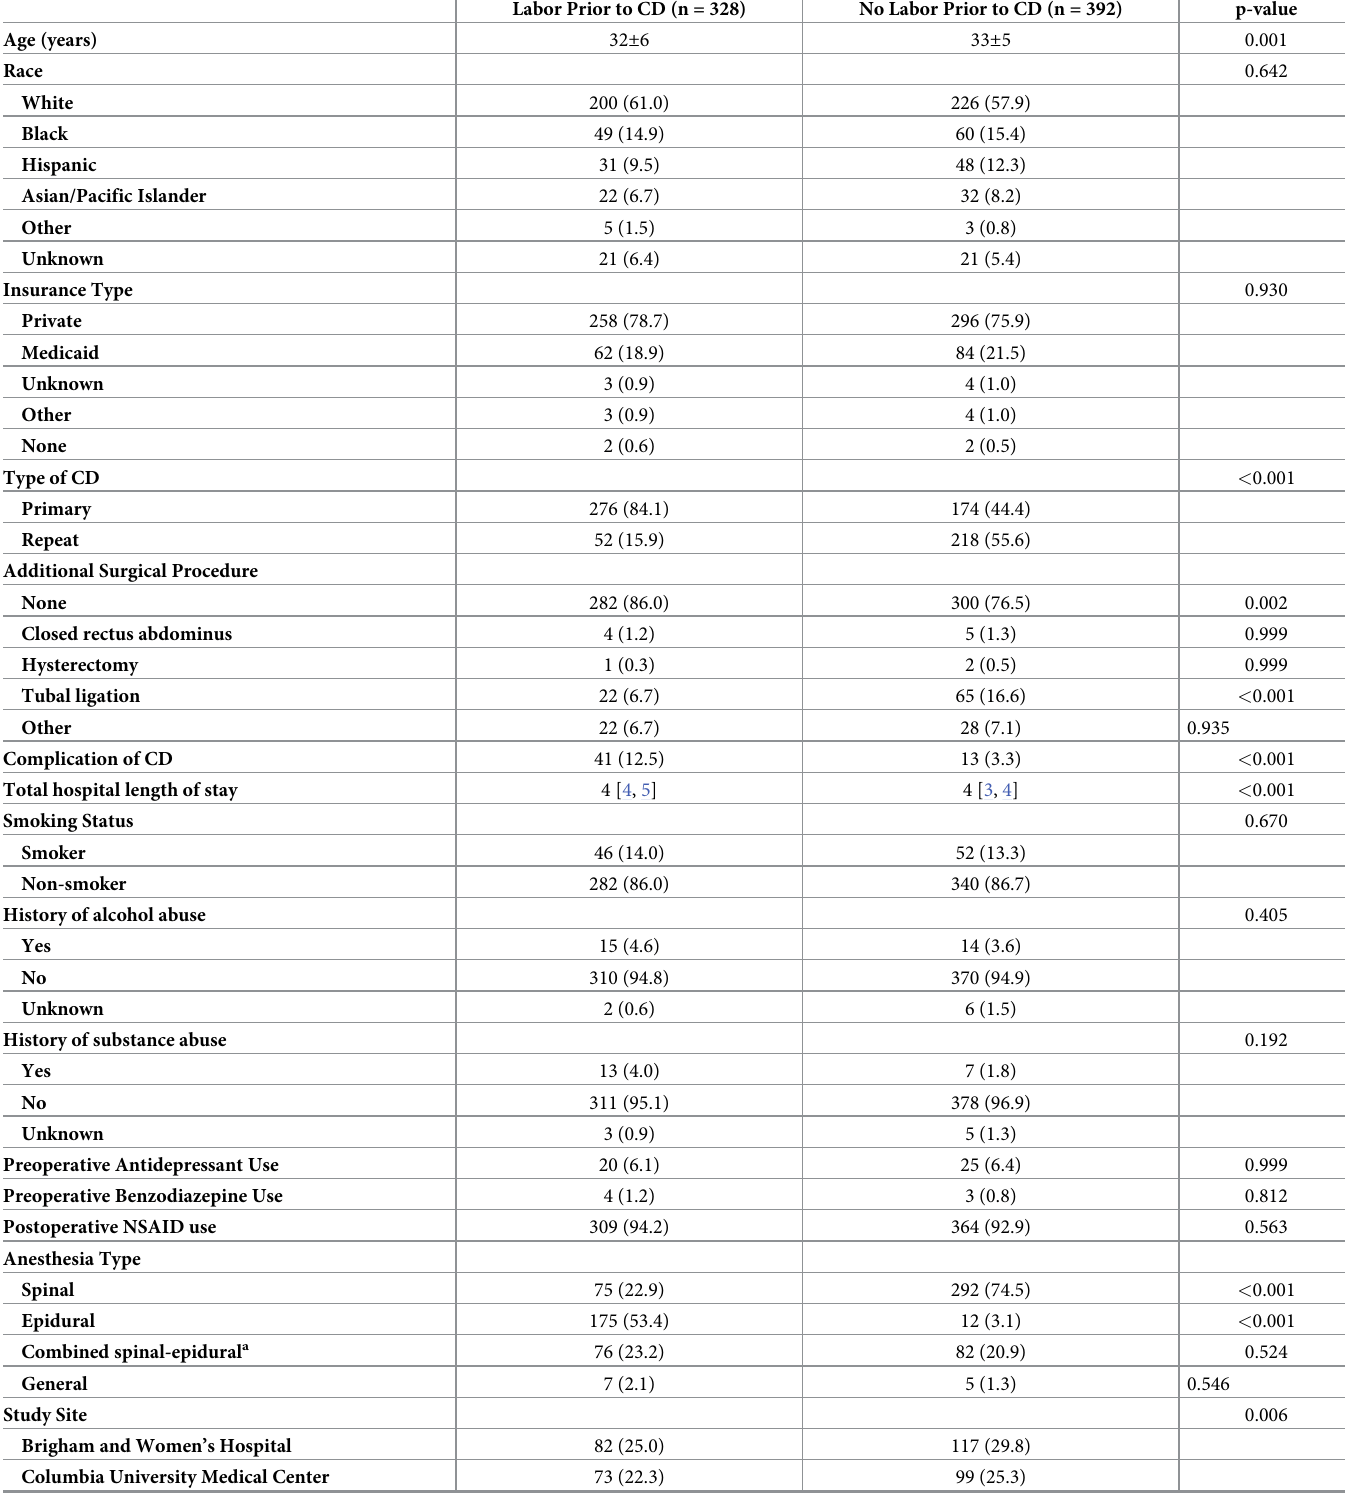
Table 1. Characteristics of patients who labored or did not labor prior to cesarean